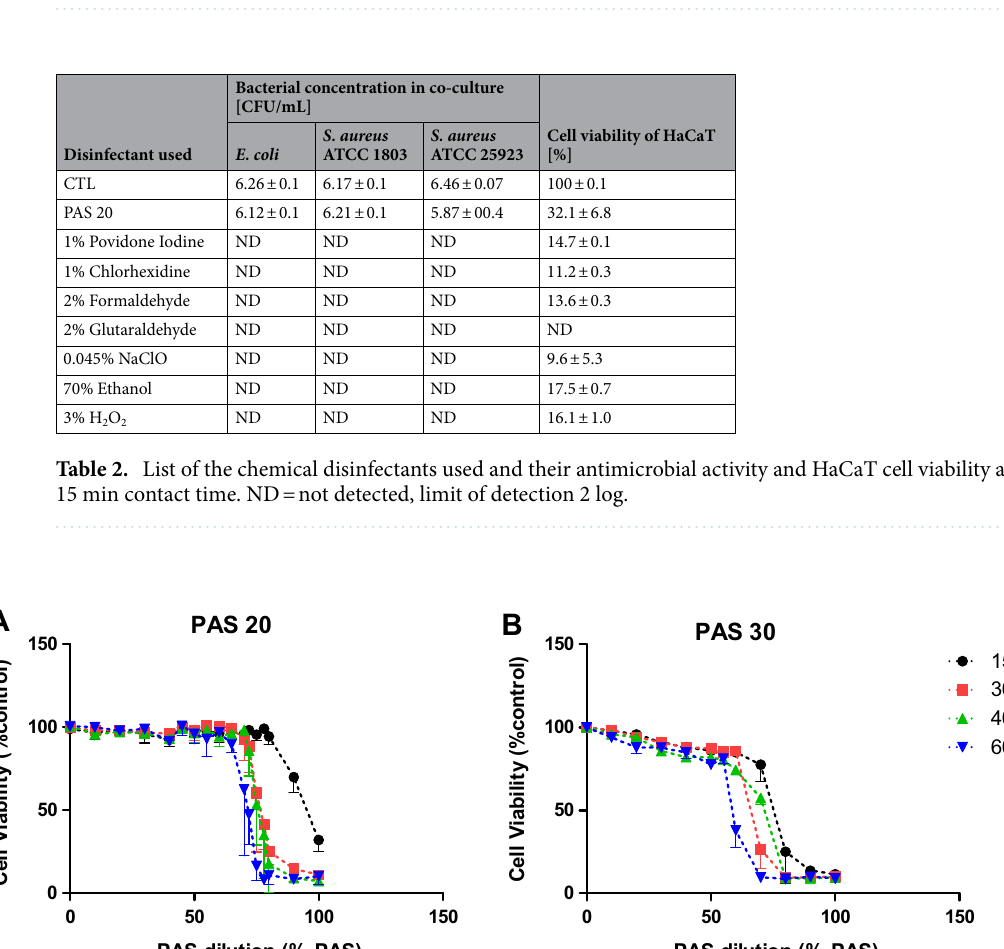
Disinfectant used